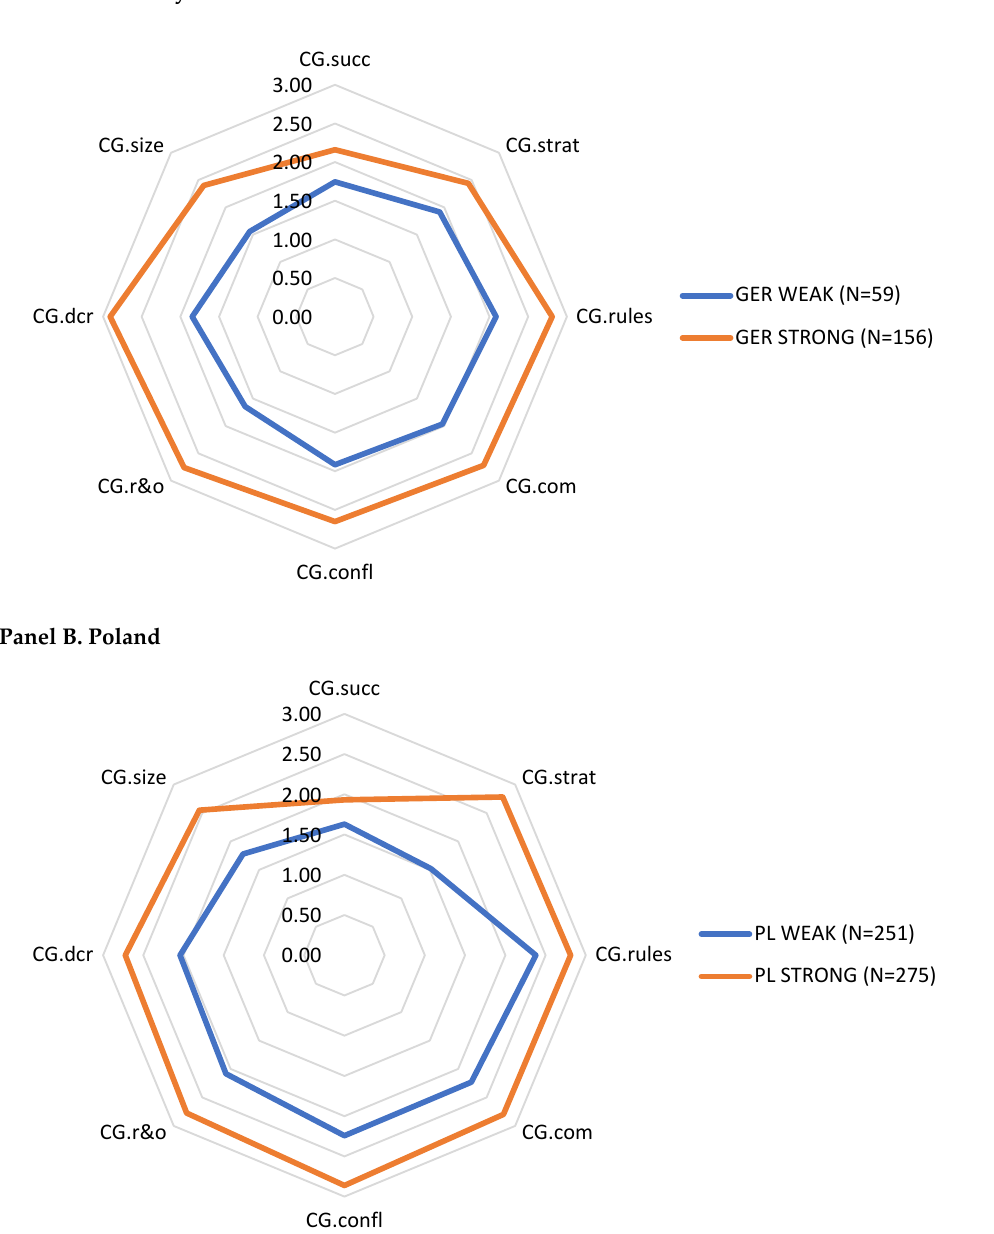
Figure 6. Clusters of weak and strong corporate governance mechanisms (mean values of the scores, for Germany and Poland).